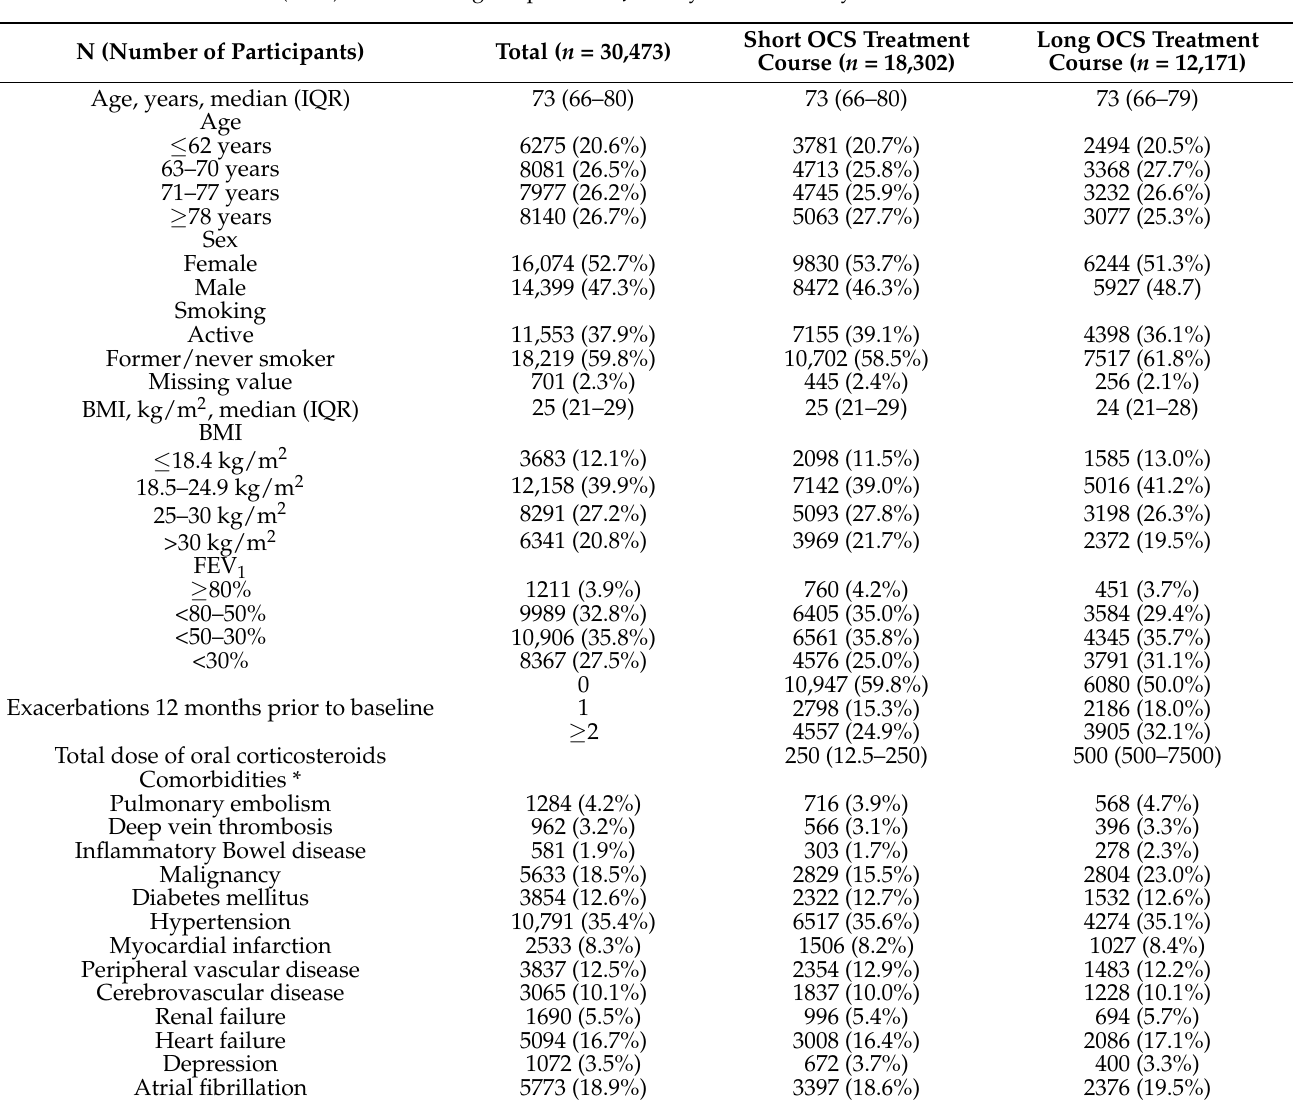
Table 1. Baseline characteristics of outpatients with chronic obstructive pulmonary disease who were treated with a long vs. short oral corticosteroid (OCS) course during the period of January 2010–February 2018. N (Number of Participants) Total ( n = 30,473)